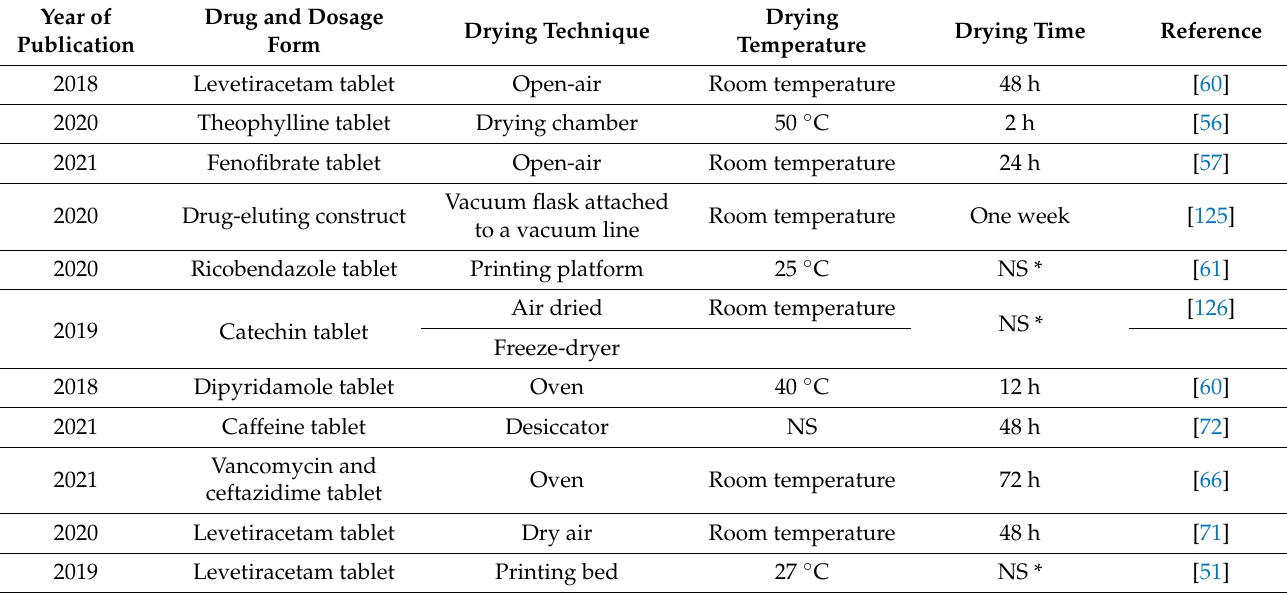
Table 2. Drying conditions of some 3D-printed drug dosage forms produced using the SSE